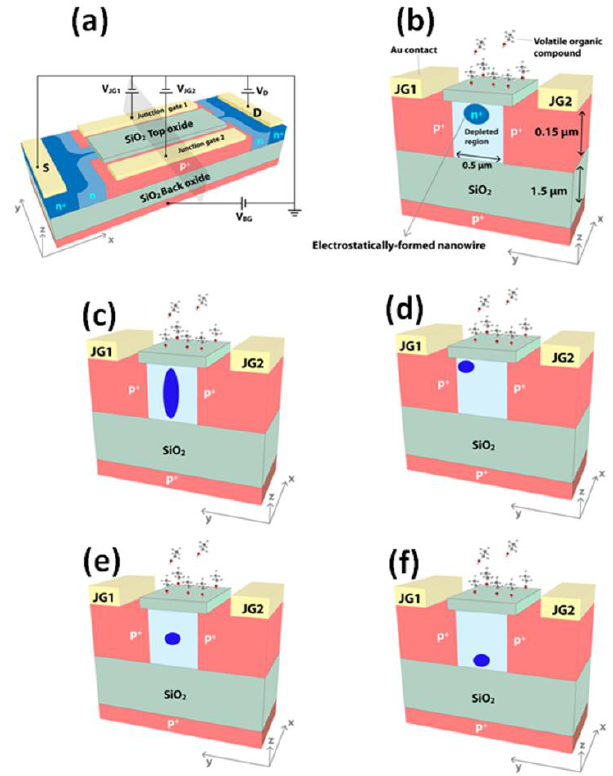
Figure 1. Design and possible modes of operation of an electrostatically formed nanowire (EFN) gas sensor. ( a ) EFN gas sensor with an electrical biasing configuration; ( b ) small EFN at the top of